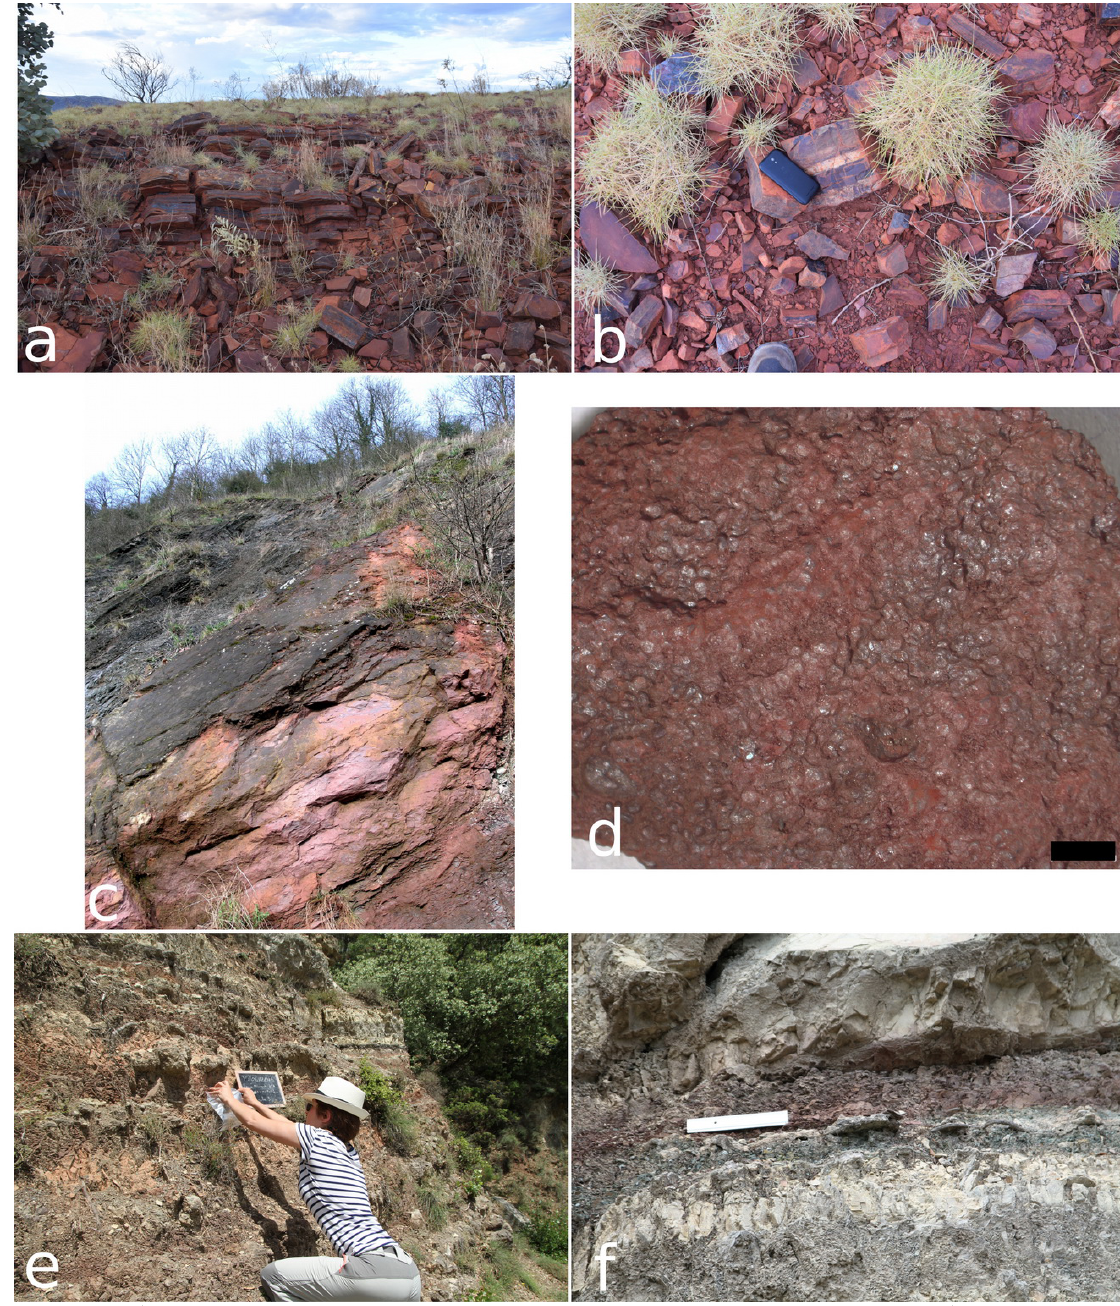
Figure 2. a-b) Banded Iron Formation, Rio Tinto’s Marandoo mine, Western Australia, c-d) Oolitic ironstone (Clinton type) interbedded between Frasnian and Lower Famennian shales, Huy, Wallonia, Belgium, c) about 6 m high, d) scale bar; 2 mm e-f) Lias ferruginous marl interbedded with limestone, Molière, Gard, France, scale bar: 20 cm. Photos: a & b: A. Chassin de Kergommeaux, c: E. Goemaere, d to f: H.